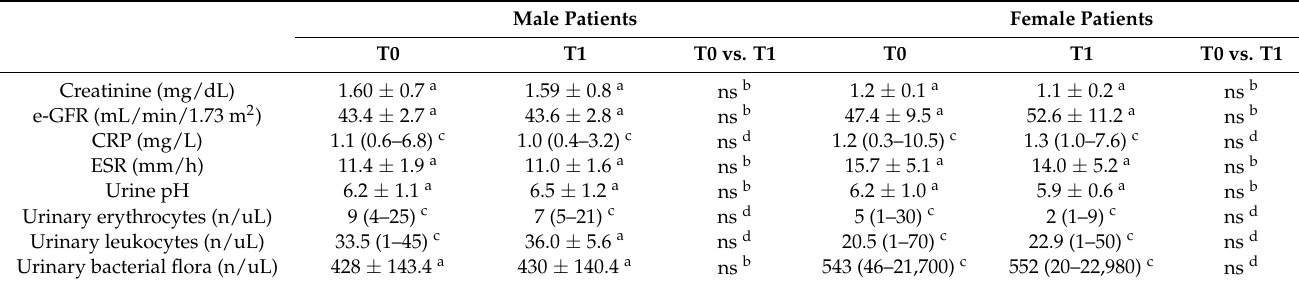
Table 4. Laboratory parameters of control group divided in two subgroups according to gender.